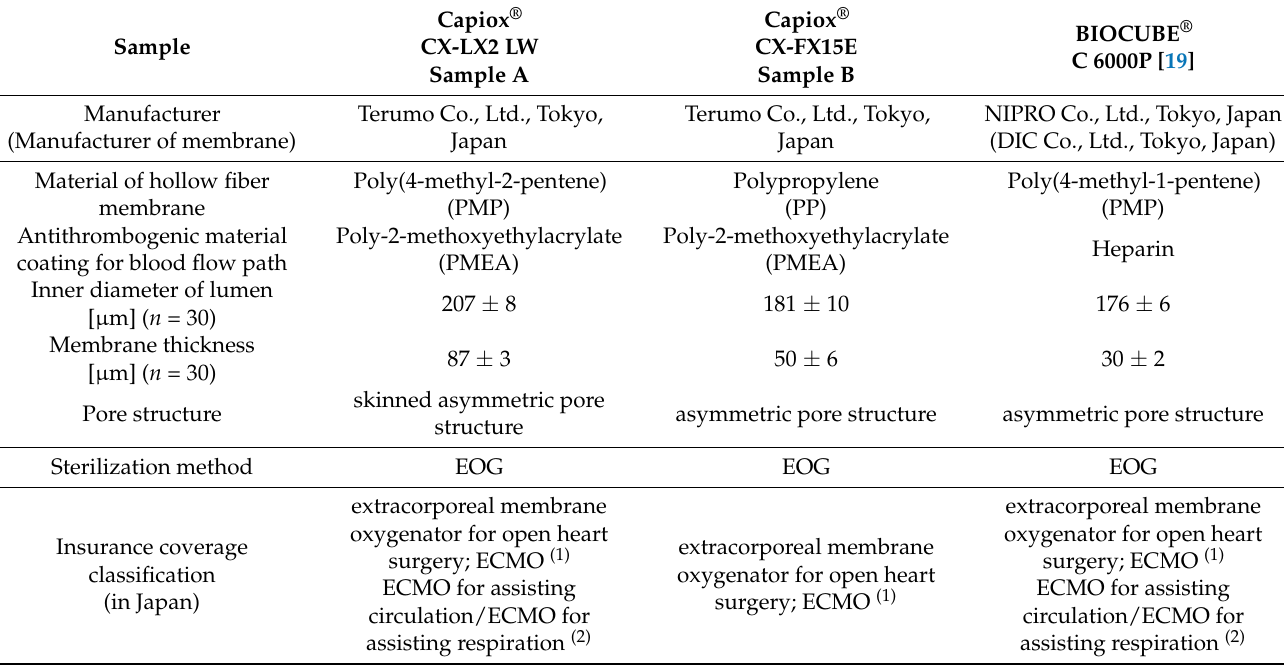
Table 1. Specification of hollow fiber membranes for membrane oxygenators.